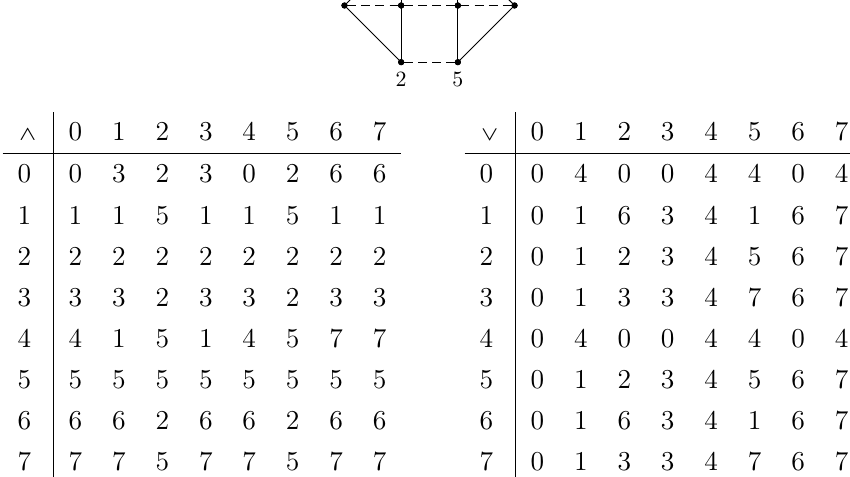
and its right-handed version is named Y 2